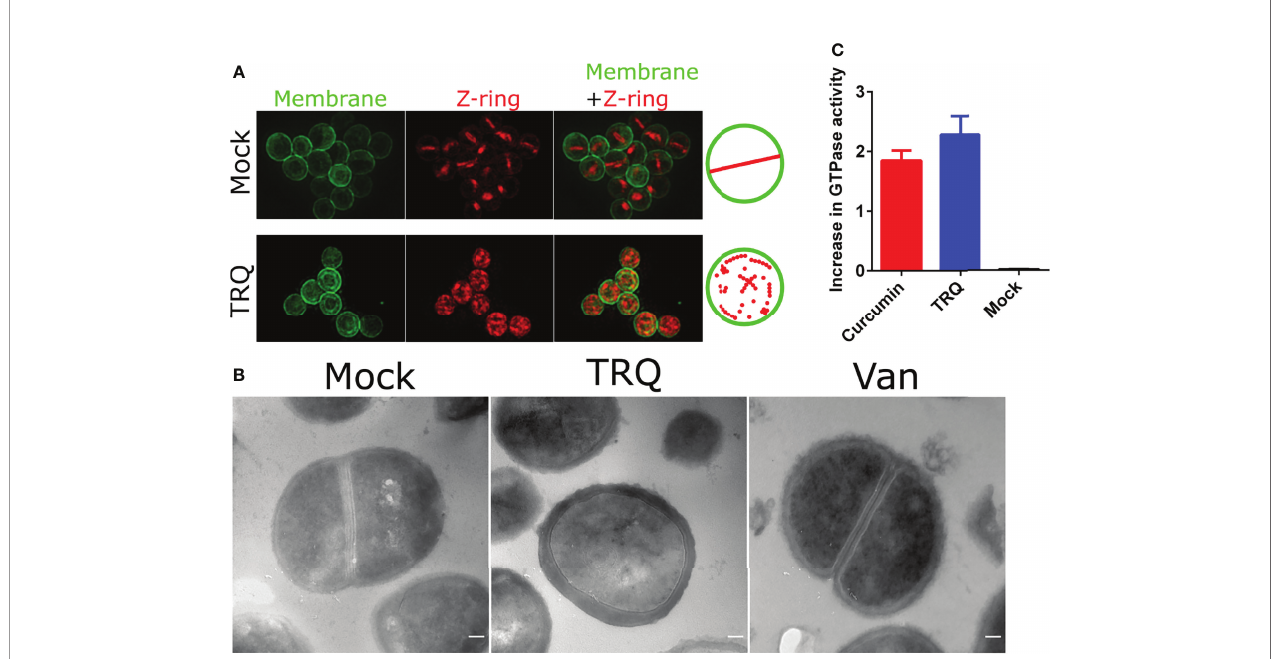
FIGURE 2 | TRQ inhibits cell division in S. aureus. ( A ) Z-ring localization in S. aureus upon TRQ treatment (1/16 dilution) compared to mock using structured illumination microscopy (SIM). First column: membranes visualized by Nile Red; second column: Z-ring formation visualized by WGA-488; third column: overlay, membrane and Z-ring visualization. Depictions of Z-ring localization patterns are to the right of the panels (B) TEM analysis of TRQ-treated (1/16 dilution) S. aureus cells. A negative control (mock) and an antibiotics (Vancomycin, van) were used as controls. Results showed that TRQ could target cell division compared to vancomycin. Scale bar, 100 nm.